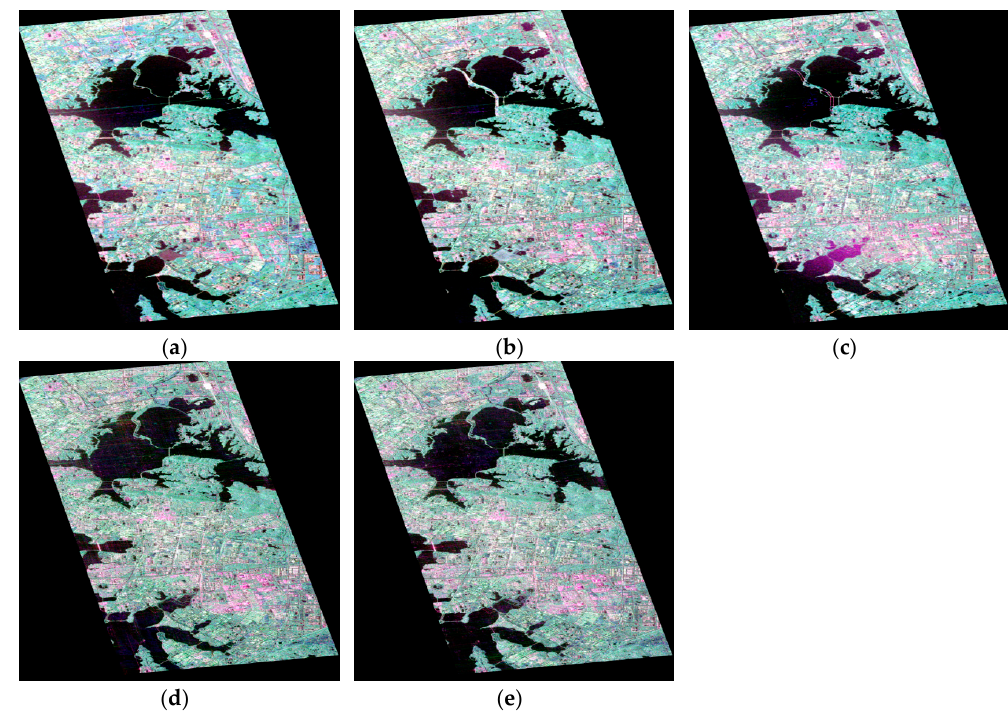
Figure 3. RADARSAT-2 PolSAR images acquired on ( a ) 7 December 2011; ( b ) 25 June 2015; and ( c ) 6 July 2016; and GF-3 PolSAR images acquired on ( d ) 30 April 2017; ( e ) 29 May 2017.